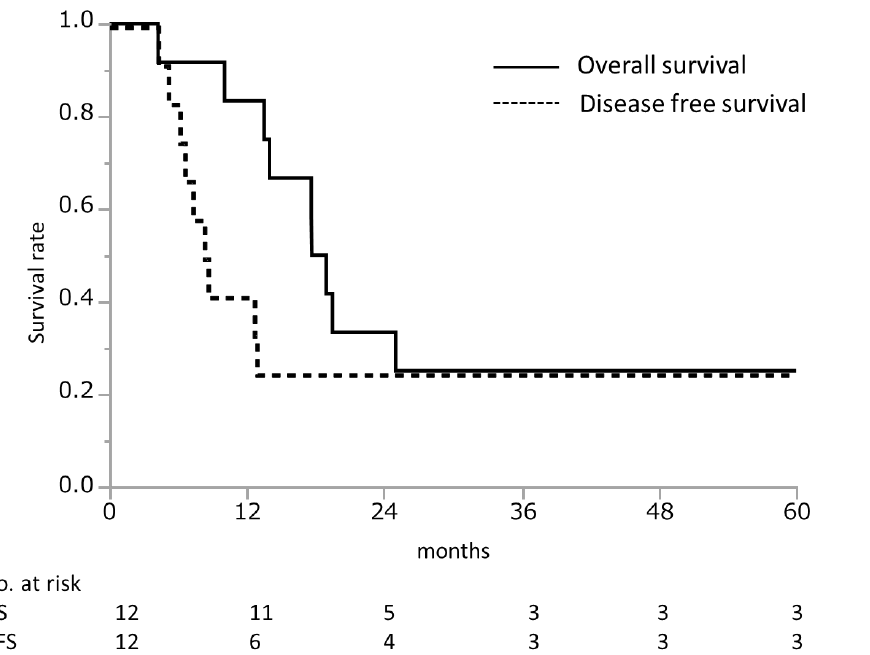
Figure 4. Overall survival and disease-free survival after conversion surgery. The median survival time was 18.3 months and disease-free survival was 8.4 months after conversion surgery in 12 patients. In both groups, pre-treatment CA19-9 levels ranged from 1.0 to 18,289 U/mL, and 17 patients had normal CA19-9 levels. When patients with normal CA19-9 levels were excluded, the median value of percent change in CA19-9 levels during first-line chemother- apy was − 52.1% (range: − 99.8% to 1072%) in 79 patients. A significant difference in the CA19-9 percent change between patients who underwent conversion surgery ( − 92.5%; range: − 99.8% to − 75.7%) and patients who did not undergo resection ( − 51.0%; range: − 99.6 to 1071) was observed. Interestingly, CA19-9 levels decreased more than 75% from baseline among patients who underwent conversion surgery (Figure 5).